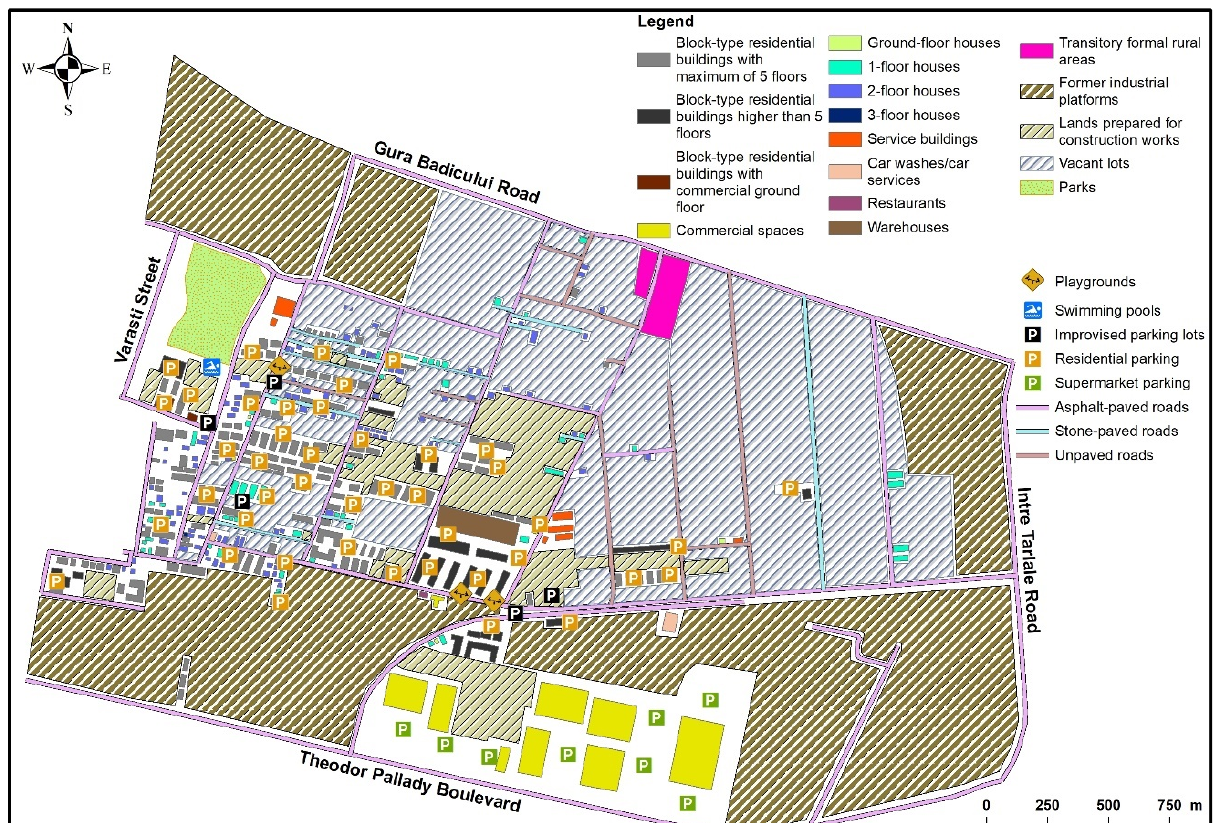
Figure 4. Residential features of the Noul Titan area.